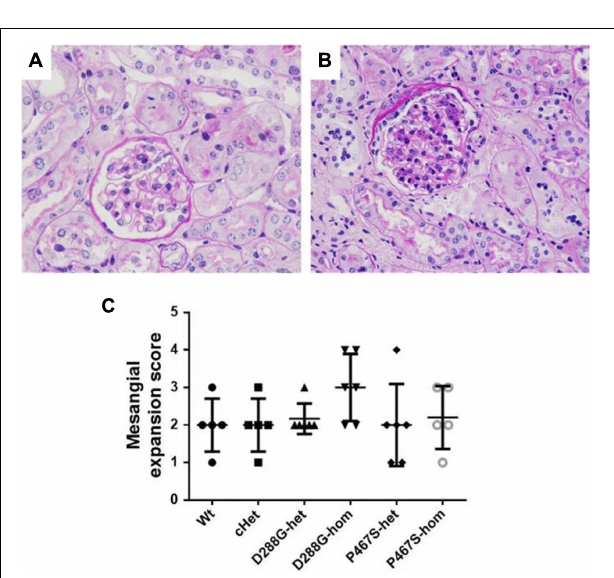
FIGURE 7 | Mesangial expansion in the mice of CFI-D288G/P467S cHet and other genotypes after LPS treatment. (A,B) PAS staining showing normal glomeruli in mouse kidney (A) and a glomerulus with mesangial expansion (B) (x600). (C) Quantification of mesangial expansion in the 6 groups of mice. Wt, n = 5; cHet, n = 5; D288G-het, n = 6; D288G-hom, n = 6; P467S-het, n = 6; P467S-hom, n = 5. Kruskal-Wallis test was used for statistical analysis, showing no significance among groups ( p = 0.307), although the D288G homozygote group tended to have a higher score than the other